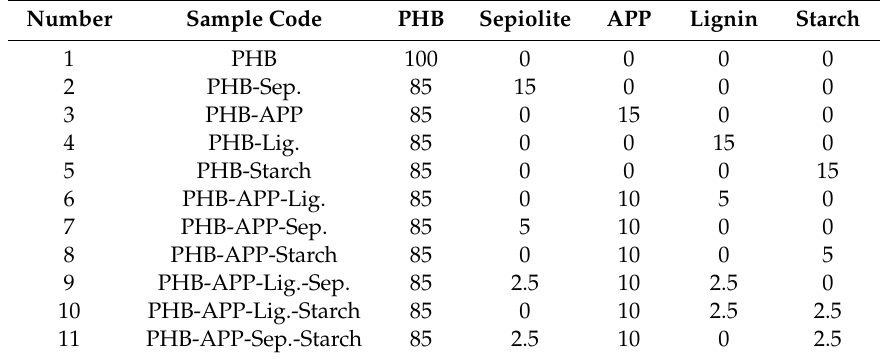
Table 1. Names and compositions of the PHB-based composite samples prepared in this